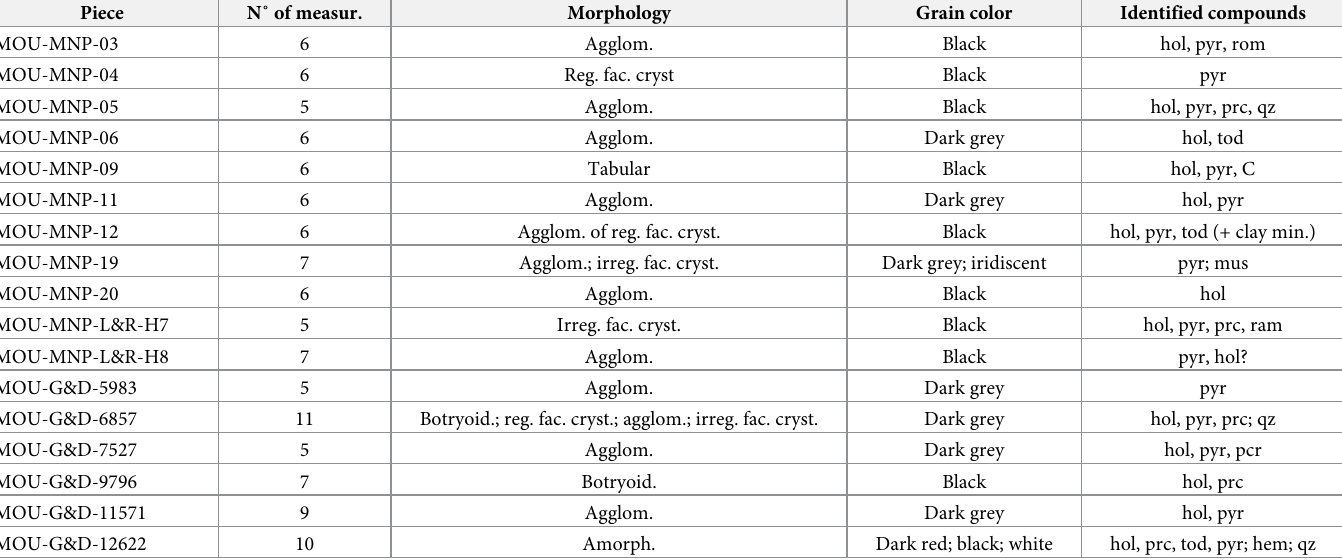
Table 4. Results of μ -RS analyses of black lumps from Le Moustier. Piece N˚ of measur.